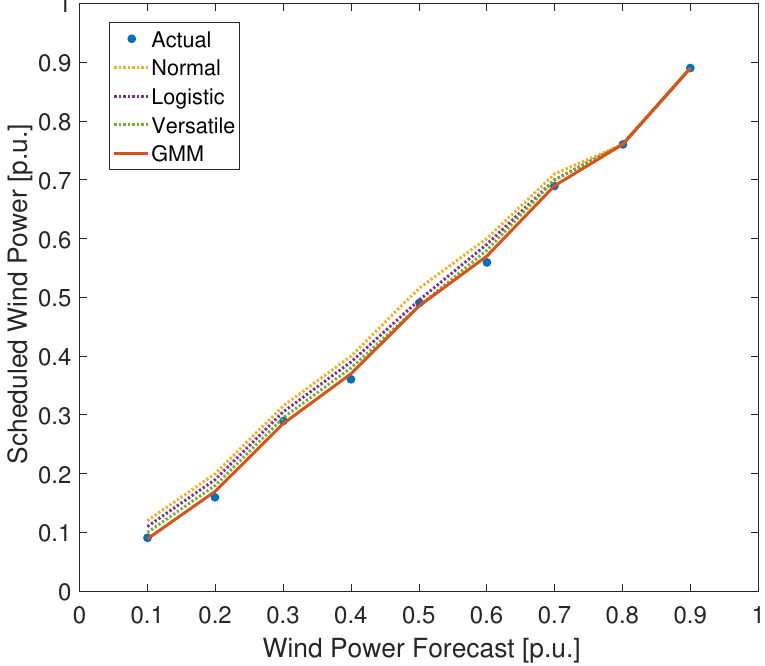
Figure 5. Scheduled wind power generation versus wind power